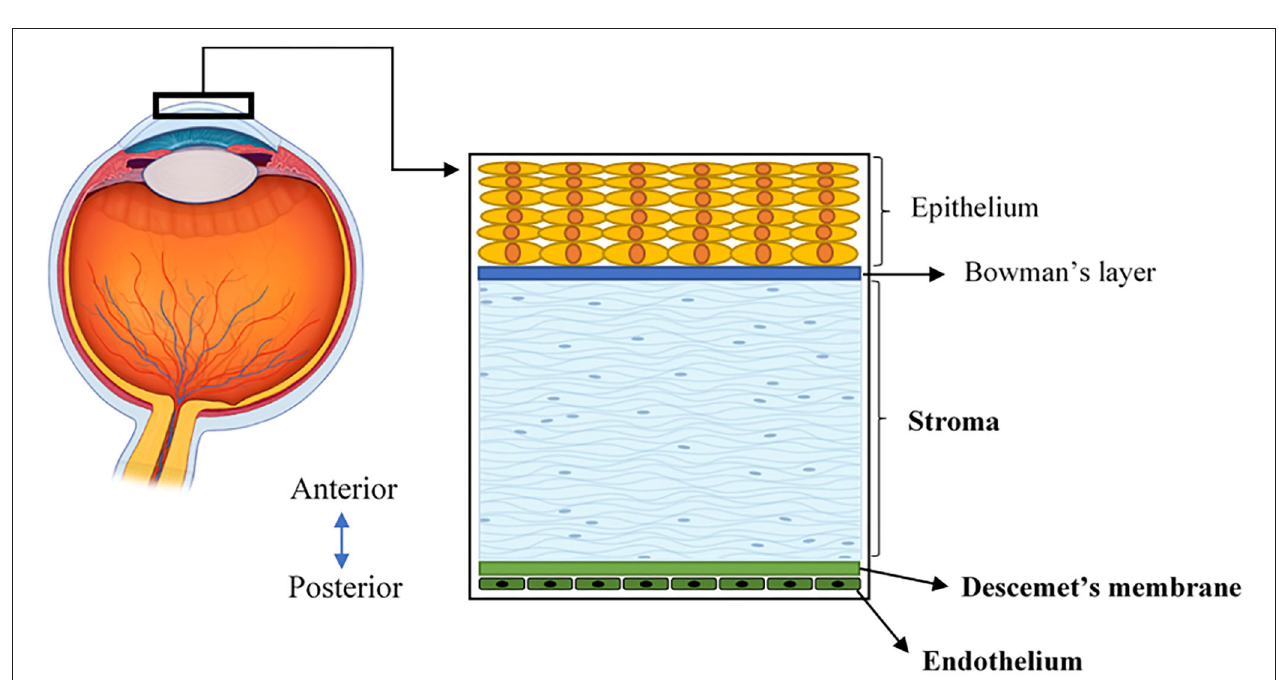
FIGURE 1 | A schematic illustration of the human cornea, located at the front of the eye and consisting of five layers.